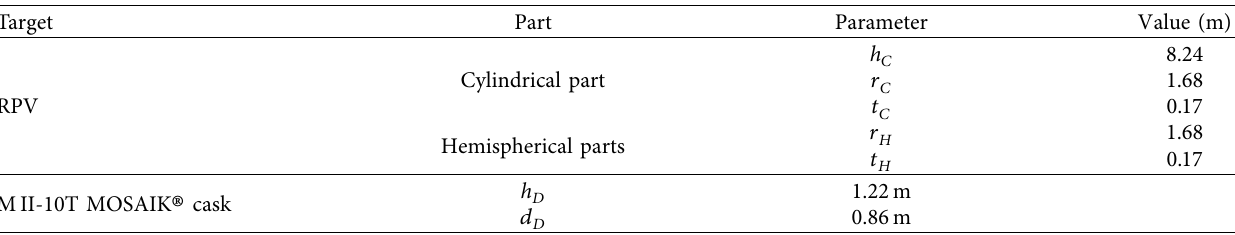
Left and right walls Total Table 3: Geometries and dimensions of the RPV and storage container assumed for comparison with the past study [12]. Target